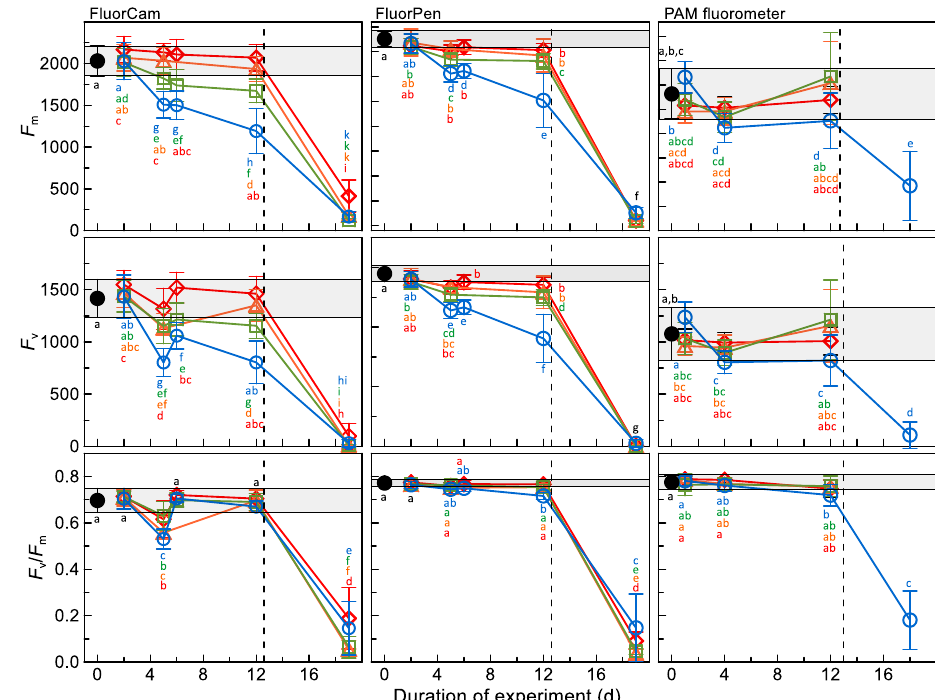
Figure 2. Means (±SD; n > 6) of maximum ( F m ) and variable ( F v ) fluorescence and of the potential maximum photochemical efficiency of PSII ( F v / F m ) of banana fruit measured with FluorCam (left column; pixel means of the entire fruit), FluorPen (mid column) and with PAM-fluorometer (right column) during cold storage ( circles: 5 °C; squares: 10 °C; Δ triangles: 11.5 °C; diamonds: 13 °C) and shelf life. The vertical dashed line indicates the end of cold storage on day 12 of the experiment. The filled circles reflect the means (the grey horizontal bar shows the respective SD) of all bananas ( n = 76), measured before storage. Different small letters indicate significant ( p < 0.05) differences between means.